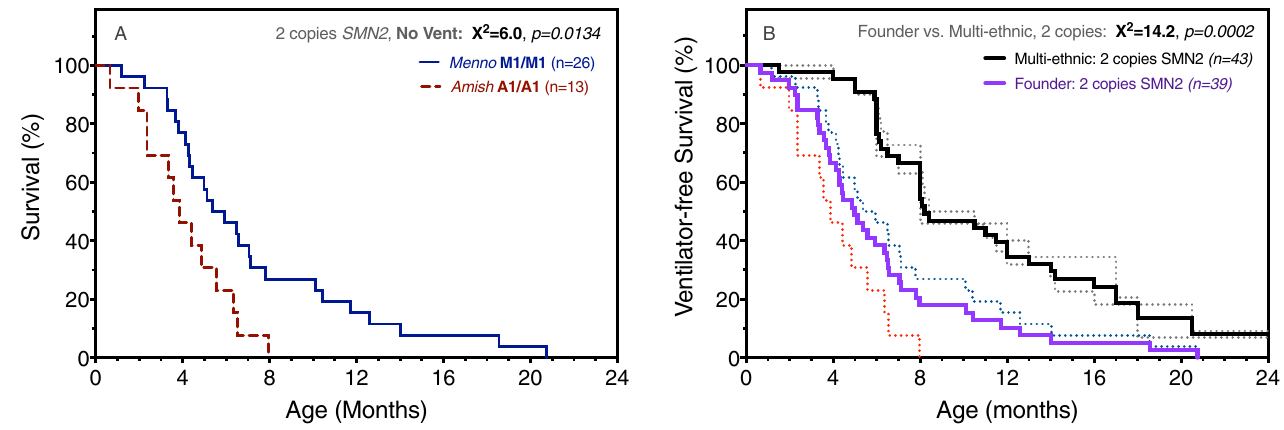
Fig 7. Survival comparisons among Amish, Mennonite, and outbred cohorts. (A) For infants who received no gastrostomy or ventilatory support, median survival of A1/A1 (dashed red; n = 13) and M1/M1 (solid blue; n = 26) homozygotes was 3.9 and 5.7 months, respectively (chi-squared 6.0, p = 0.0143). (B) We compared aggregate (solid purple) survival data for A1/A1 and M1/M1 ‘founder’ cohorts to ventilator-free survival from two ‘multi-ethnic’ outbred cohorts (References 29 and 10) that in aggregate (solid black line) encompass 43 SMA infants with 2 copies of SMN2 . When permanent ventilatory support (i.e. (cid:21) 16 hours daily) is taken as a proxy for death, Amish and Mennonite founder populations had shorter median survival (5.0 versus 8.2 months; chi-squared 14.2, p =